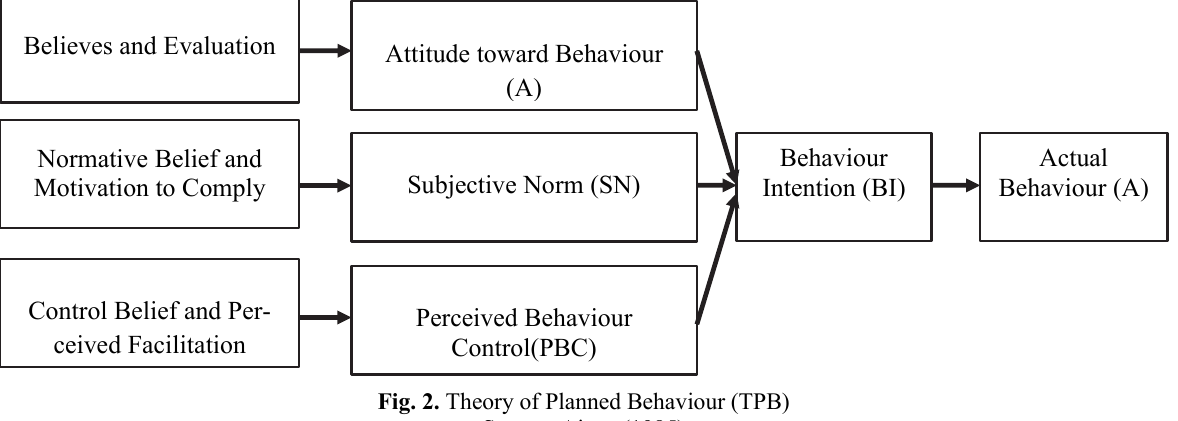
Fig. 2. Theory of Planned Behaviour (TPB) Source: Ajzen